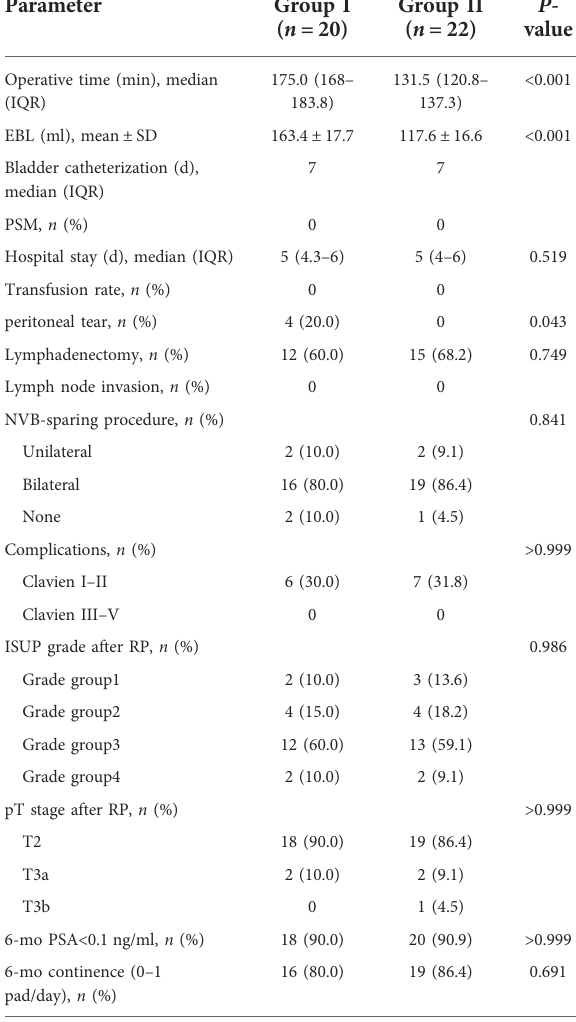
TABLE 2 Comparisons of intraoperative and postoperative data, complications between not using extraperitoneal tissue retraction technique (group I) and using extraperitoneal tissue retraction technique (group